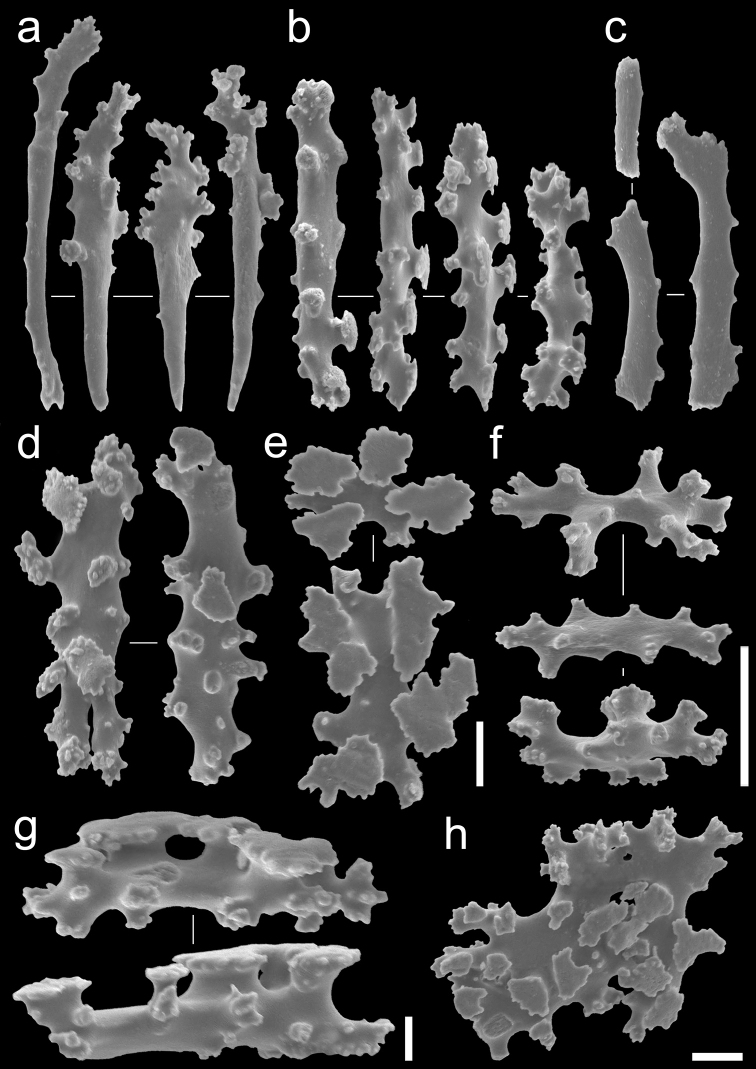
Sclerite types observed in Laeta
waheedae gen. nov. et sp. nov., NSMT-Co 1680, holotype: a rods of calyx b rods of calyx c anthocodial rods d table-radiates of calyx e table-radiates of calyx, top view f rods of calyx g table-radiates of calyx, lateral view h fragment of fused table-radiates of the stolon. Scale bars 0.05 mm (a–c, f); 0.02 mm (d–e); 0.01 mm (g); 0.02 mm (h).